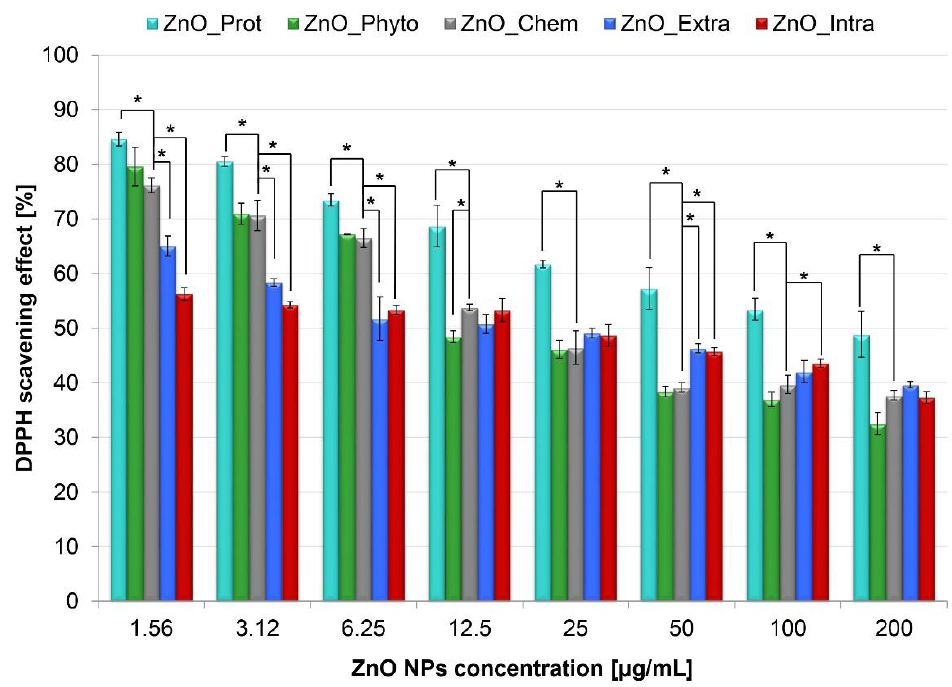
Figure 1. Antioxidant activity (%) of bare and functionalized ZnO NPs (at 200, 100, 50, 25, 12.5, 6.25, 3.12 and 1.56 µg/mL concentrations). The values are expressed as mean ± SD values of three independent experiments ( n = 3); * p < 0.001 compared to bare ZnO NPs (ANOVA).